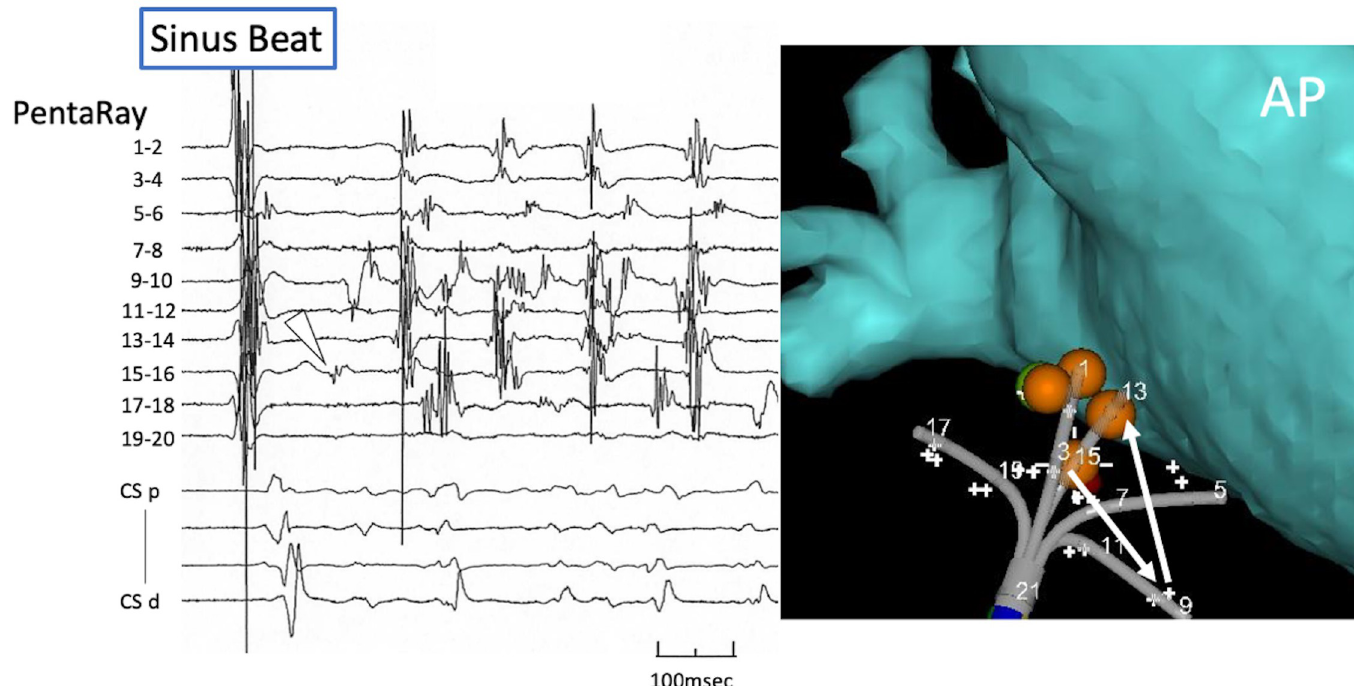
Fig 4. Left panel: The intracardiac electrograms during the onset of AF by the non-pulmonary vein trigger. The first beat was sinus rhythm. The earliest potential of the non-pulmonary vein trigger was recorded by PEN15-16 (white arrowhead). The next activated potential was recorded by PEN 9–10 and then PEN 13–14 was activated. Right panel: The location of the PEN. The white arrows show the activation sequence of the non-pulmonary vein trigger. AP, anterior-posterior view; CS, coronary sinus; PEN, PentaRay 1 NAV catheter.